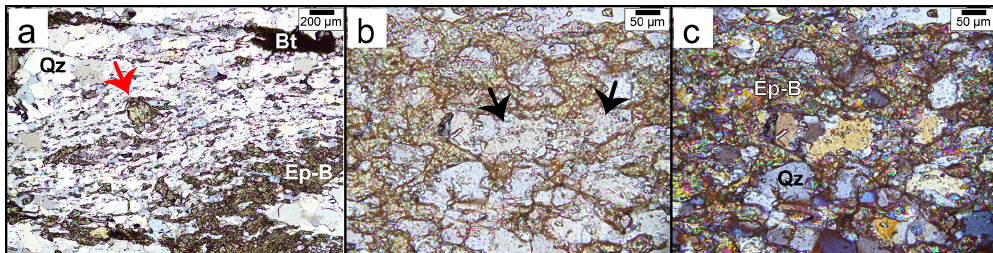
Figure 6. Transmitted-light microphotographs of layer 2. (a) Detail of the epidote microfold, with oval epidote grains hosted by dynamically recrystallized quartz and their long axes oriented consistently with the microfold axial planes. Red arrow: euhedral epidote grain. Overlapped images in plane-polarized and cross-polarized light. (b–c) Details of quartz enclosures among epidote grains in plane-polarized (b) and cross-polarized (c) light. The black arrows point at epidote and fluid inclusions in quartz. Bt; biotite; Ep-B: Epidote-B; Qz: quartz.